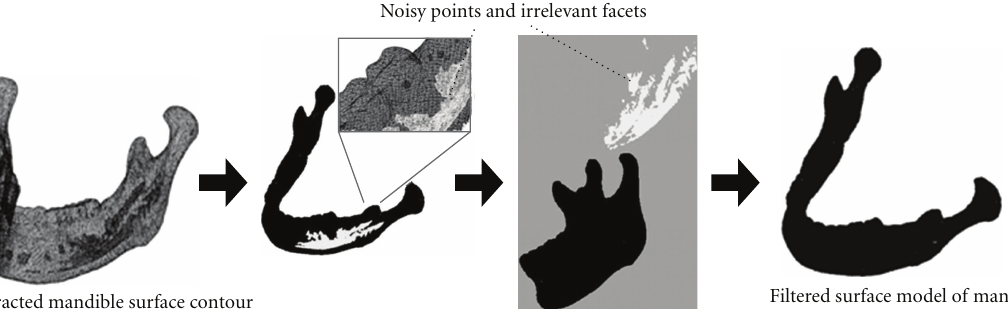
Figure 7: An illustrative example of separating noisy point data and irrelevant facets from the designated mandible tissue surface.